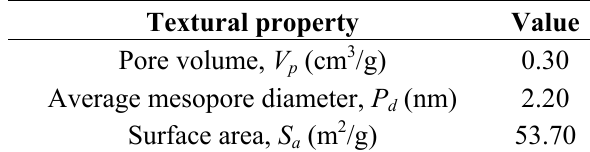
Table 2. Textural properties of WEAX